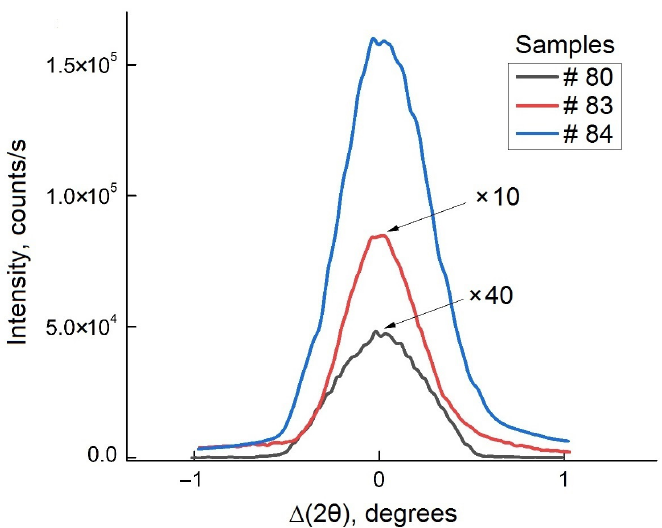
Figure 7. Experimental GID curves of (004) reflection for samples #80, #83, #84. For clarity, the intensities of peaks #83 and #80 are multiplied by 10 and 40, respectively.